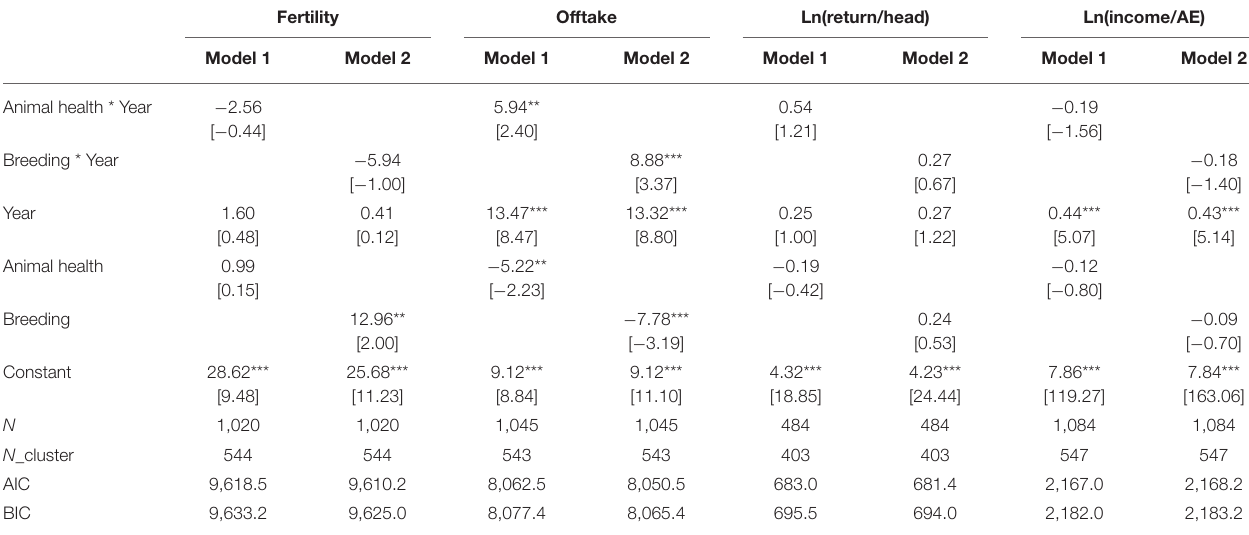
TABLE 5 | DiD with basic fixed-effects specification without covariate.